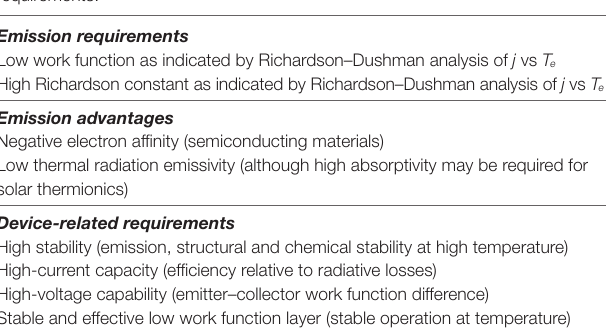
TABLe 1 | Emitter requirements and advantages, and device-related